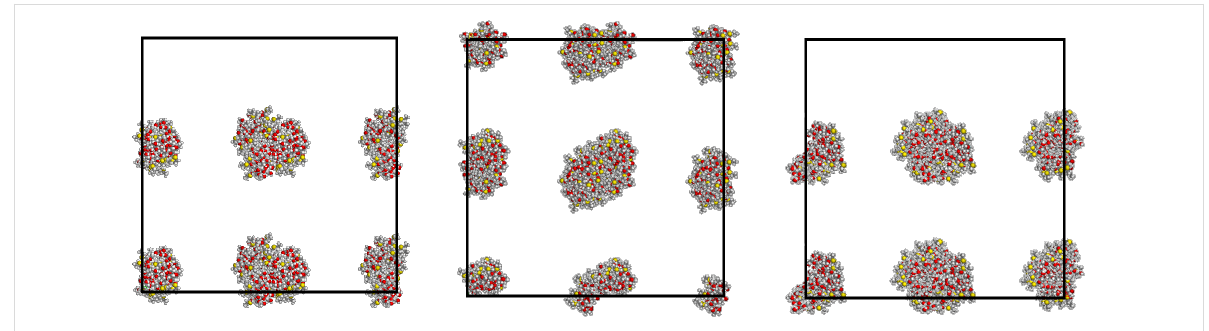
Figure 3: The first trial starting arrangement of sixty-four molecules within the large cell of 123.0 Å, symmetrically arranged in eight clusters each comprising eight molecules as obtained in the previous run with the smaller cell of 61.5 Å. The three projections are taken along the cell x -axis, the y -axis, and the z -axis from left to right. Due to the assumed cell periodicity, some clusters at the cell edges are apparently split in two smaller clusters, but they actually form eight clusters when the larger cell periodicity is taken into account.